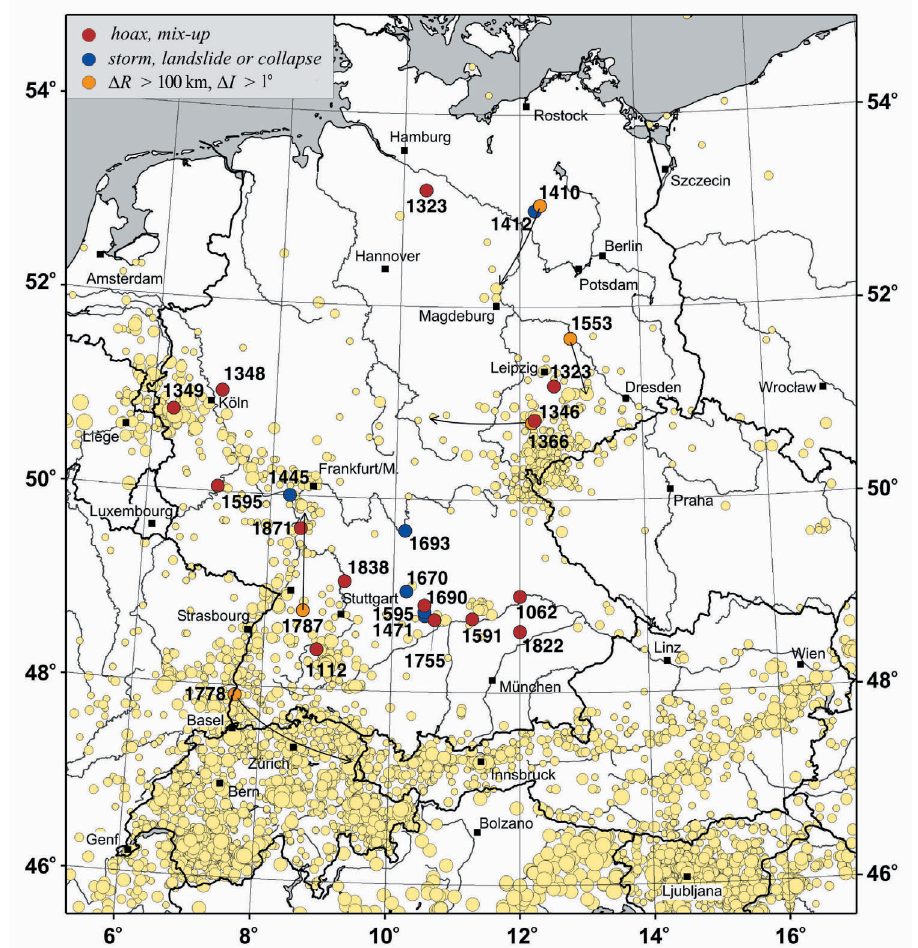
Fig. 1. Seismicity of Germany and adjacent areas (in yellow; after Grünthal and Wahlström, 2003) and a se- lection of fake quakes in Germany with a former maximum intensity larger than or equal to VI. The latter are differentiated into hoax events and mix-ups with real earthquakes (in red) mostly happening outside of Germany, misinterpreted storms, landslides or collapses (in blue), and events relocated by more than 100 km distance with an intensity deviating by more than one degree (orange). These findings were subject of papers by Grünthal to- gether with Fischer or Meier from the last ten years ( cf.